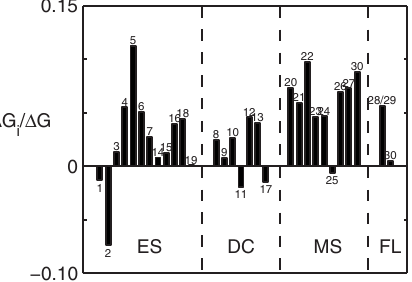
FIG. 11. Fractional difference in performance for E&M subtopics—the fractional difference in performance (cid:2) G i / (cid:2) G be- tween M&I and traditional students at GT is shown for each ques- tion on the BEMA. Positive (cid:1) negative (cid:2) (cid:2) G i / (cid:2) G indicates superior performance by M&I (cid:1) traditional (cid:2) students. The numerical labels indicate the corresponding question number in order of appearance on the BEMA. The (cid:2) G i / (cid:2) G are grouped together into one of the four topics: electrostatics (cid:1) ES (cid:2) , dc circuits (cid:1) DC (cid:2) , magnetostatics (cid:1) MS (cid:2) , or Faraday’s law and induction (cid:1) FL